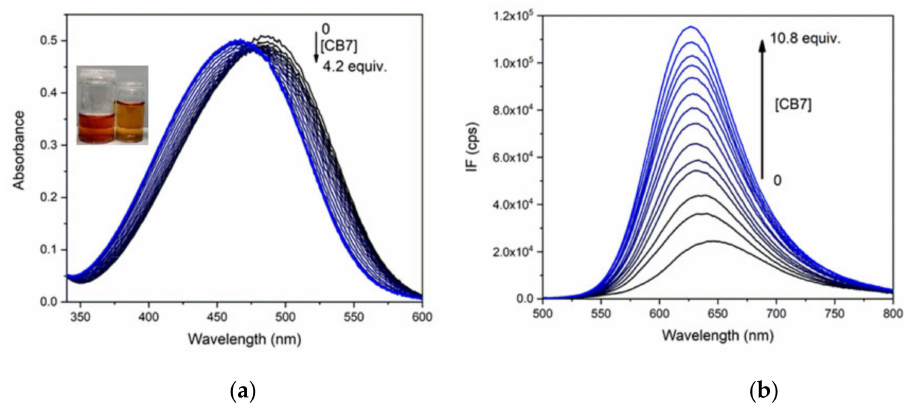
Figure 7. ( a ) Absorption spectra of 1.5 × 10 − 5 M solution of PhSt in pH 8.0 bu ff ers in the presence of 0–4.2 equiv. CB7, ( b ) fluorescence spectra of 1.0 × 10 − 6 M solution of PhSt in the presence of 0–10.8 equiv. CB7, λ ex = 468 nm, the isobestic point of the absorption